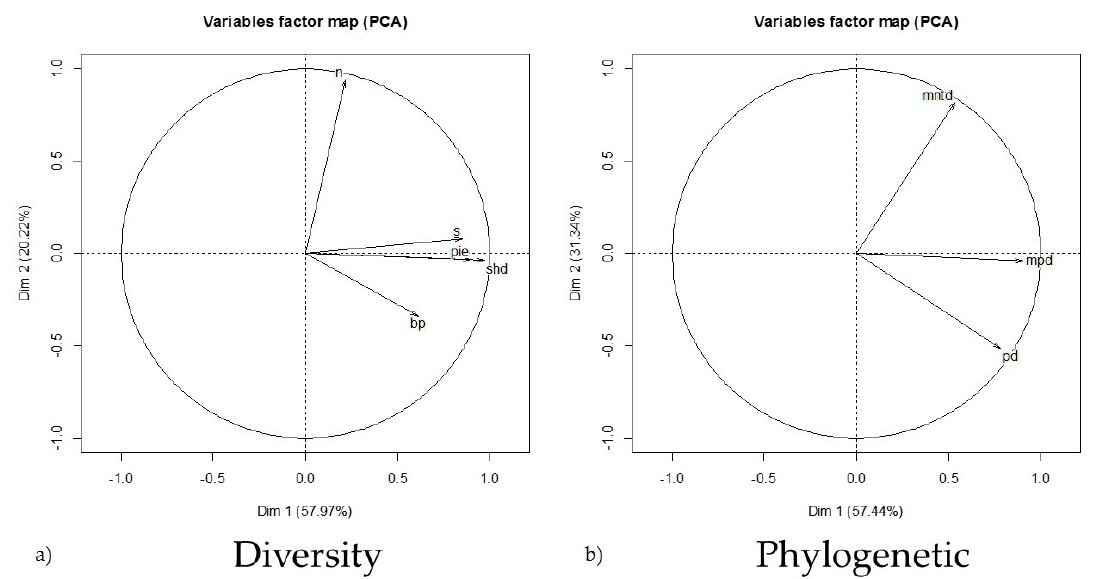
Figure 1. The results of covariate collapsing using principal component analysis (PCA) to derive eigenvectors describing small mammal assemblage diversity characteristics where dimensions one and two account for ~58% and ~20% of the variation, respectively ( a ), and phylogenetic relatedness indices where dimensions one and two account for ~57% and ~31% of the variation, respectively ( b ). These descriptors were used as predictor variables in the global model selection to account for variation in predicting the total assemblage orthohantavirus prevalence at the global scale. (n) abundance; (s) species richness; (pie) evenness; (shd) diversity index; (bp) dominance index; (mntd) mean nearest taxon distance; (mpd) mean pairwise distance; (pd) phylogenetic distance.